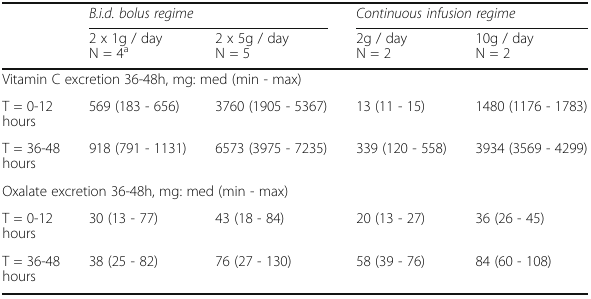
Normal oxalate excretion ≤ 20 mg/12h a Missing urine data from 1 patient because of anuric acute kidney